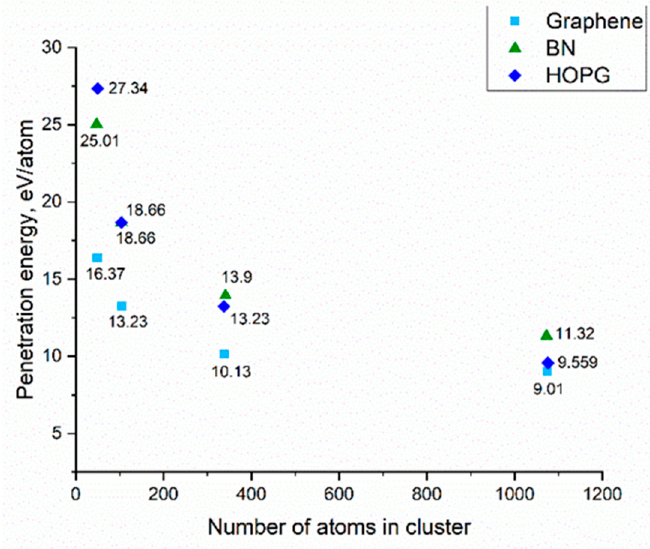
Figure 2. Threshold energy calculation results. Figure 2. Comparison of the energies of penetration of thin films by an argon cluster ion. The size of the thin film was 1000 × 1000 Å 2 . The cluster size varied from 42 to 1074 argon atoms per